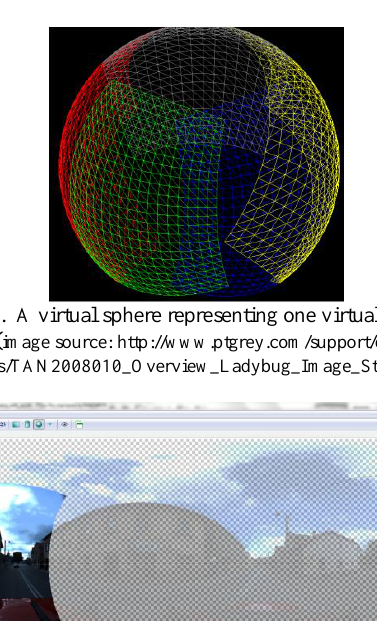
Table 1. Calibration of a virtual sphere in Hugin and PTGui.